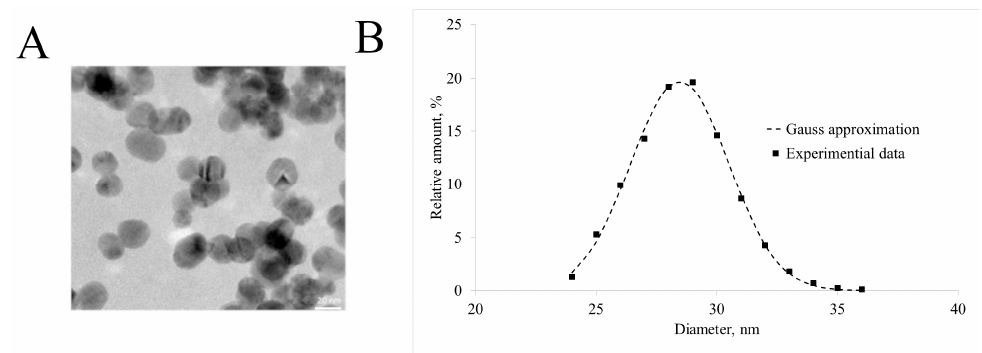
Figure 2. Nanoparticle characterization. ( A ) TEM image of the final nanoparticles. Scale bar = 20 nm; ( B ) the hydrodynamic diameter Fe 3 O 4 @Au NPs distribution and its approximation by the Gauss function.